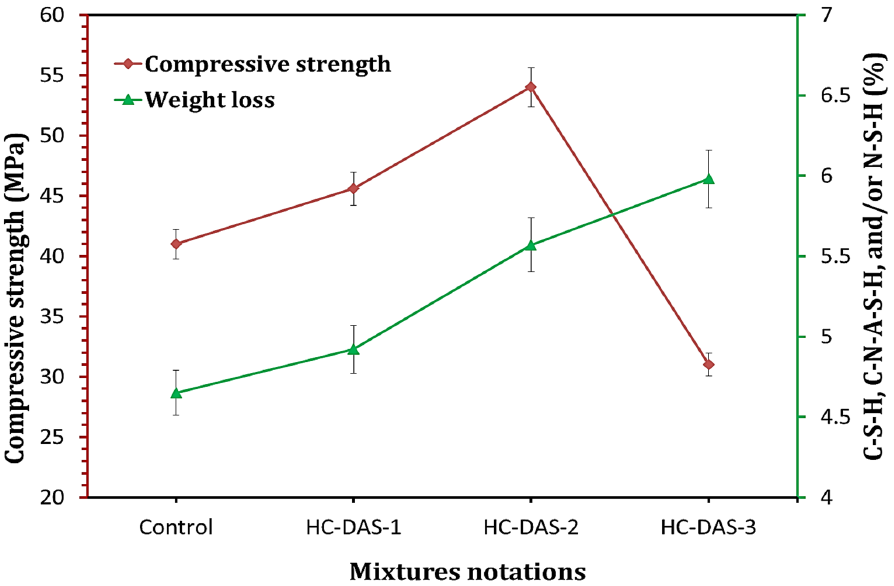
Figure 9. Relationship between weight losses of the hydration products within the hardened cement pastes and the compressive